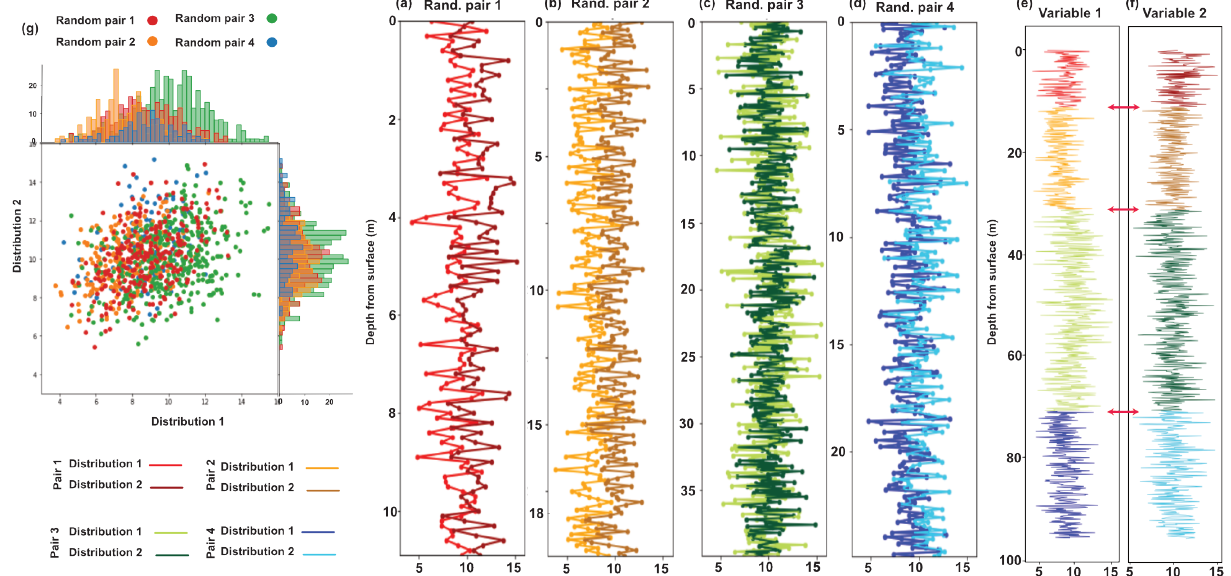
Figure 3. Synthetic dataset. ( a – d ) Pairs of correlated variables with a simulated sampling rate of 10 cm along depth. The pairs-sets have different lengths with 110, 200, 400 and 250 samples, respectively. ( e ) Synthetic variable 1 created from the concatenation of the first random distribution from the four pairs. ( f ) Synthetic variable 2 created from the concatenation of the second random distribution from the four pairs. ( g ) Scatterplot of variable 2 against variable 1. The upper and right axes of the scatterplot show the marginal